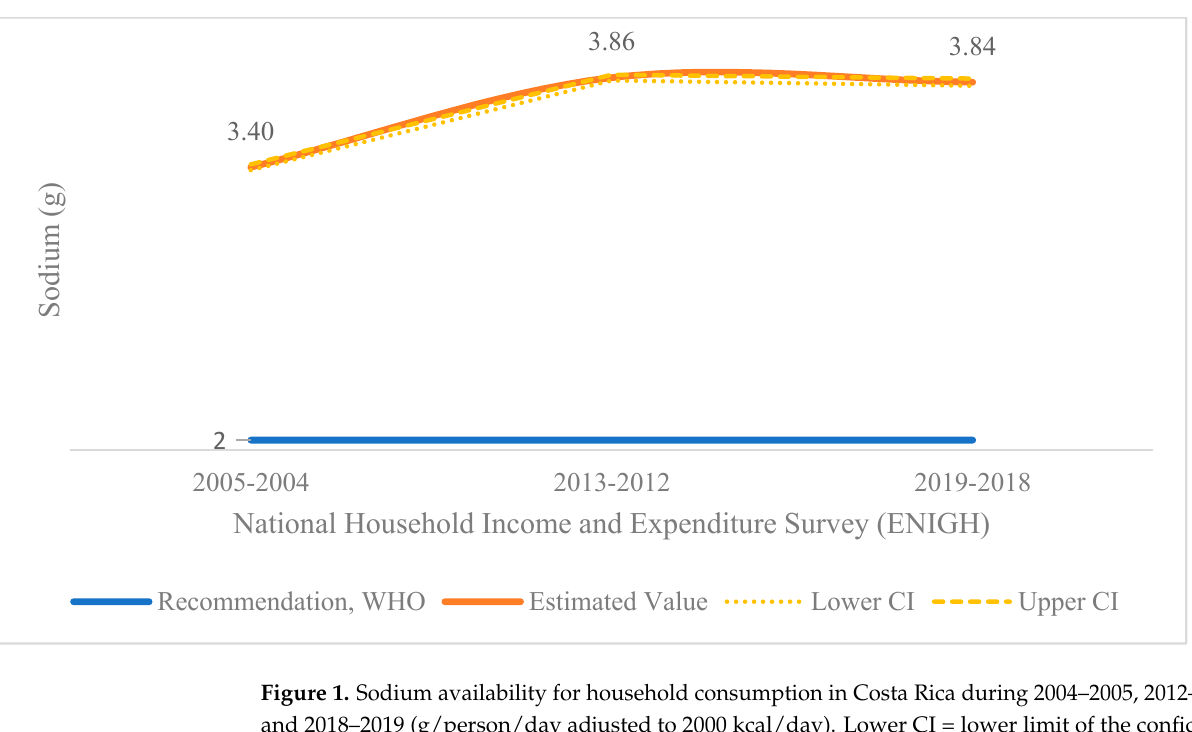
Figure 2. Sodium availability for household consumption according to zone of residence in Costa Rica during 2004–2005, 2012–2013 and 2018–2019 (g/day/person adjusted to 2000 kcal/day). Figure 3 compares sodium availability for consumption by income quintiles, with a minimum of 2.90 g/person/day in quintile V (2004–2005) and a maximum of 4.64 g/per- son/d in quintile III (2018–2019). There was no linear relationship with the income level.